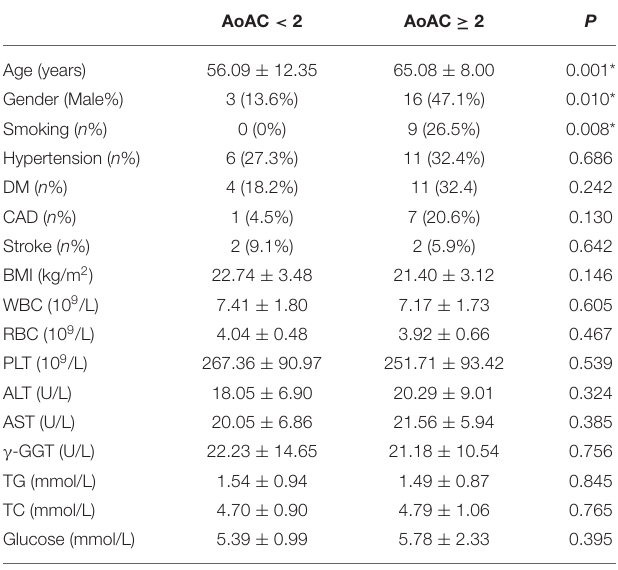
TABLE 1 | Comparation between patients with different severities of aortic calcification.